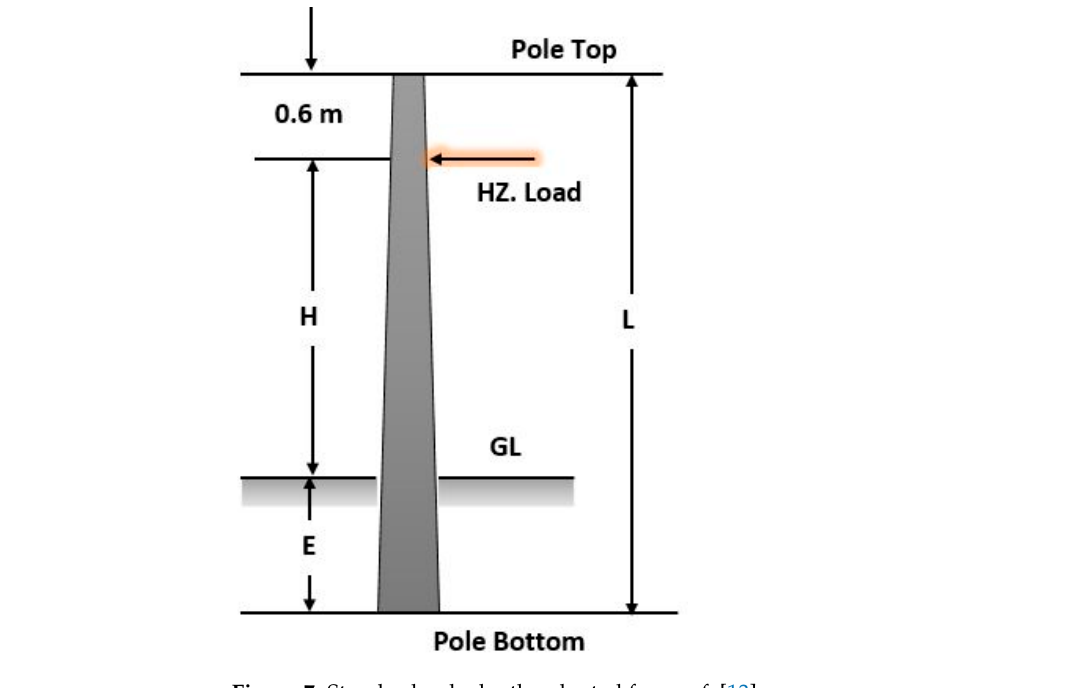
Figure 7. Standard pole depth, adapted from Ref. [13]. Table 3. Different standards of testing